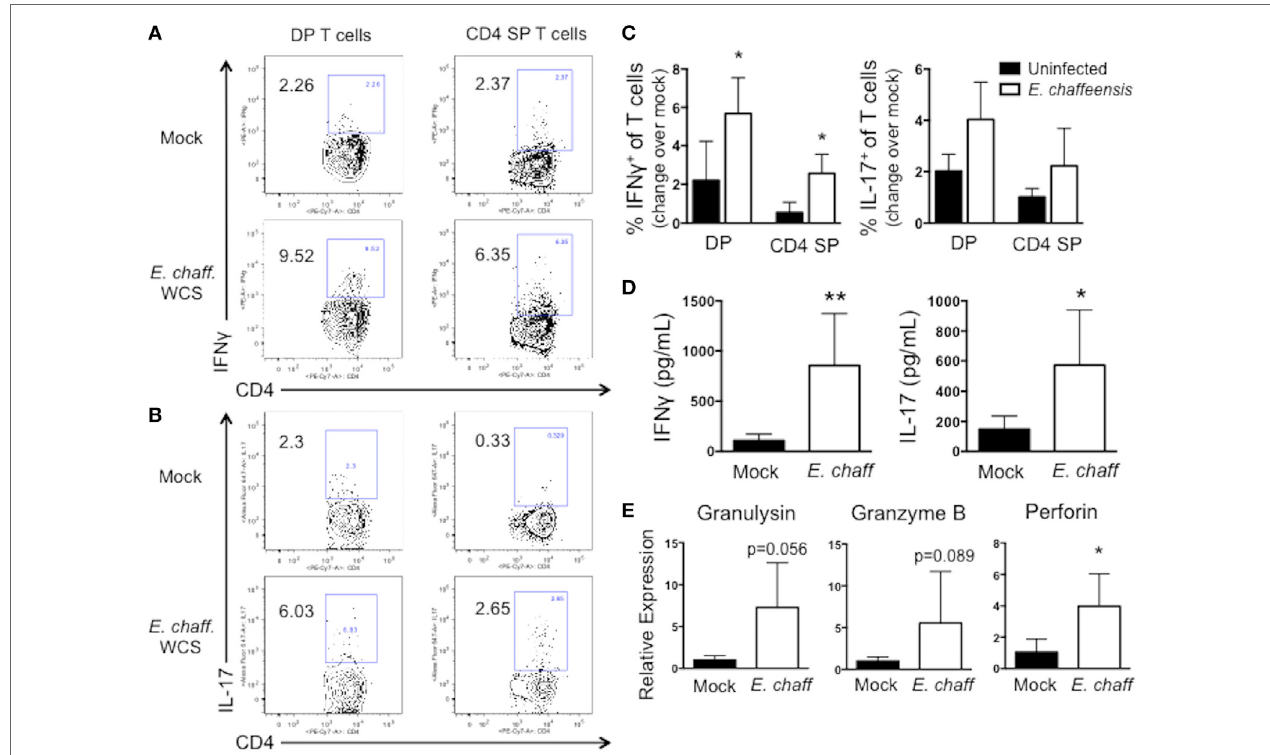
FigUre 5 | CD4 + CD8 + double-positive (DP) T cells from Ehrlichia chaffeensis infected dogs secrete IFN γ and IL-17, and upregulate expression of granzyme B and granulysin, in response to E. chaffeensis antigen. (a) On day 25 post infection, peripheral blood mononuclear cells (PBMCs) were stimulated overnight with 10 µg/ml host cell-free E. chaffeensis lysate in the presence of Brefeldin A. Mock-stimulated samples were used to correct for background cytokine secretion. Cells were fixed and permeabilized, and the frequency of antigen-specific CD3 + CD4 + CD8 + DP T cells and CD3 + CD4 + single-positive (SP) T cells producing IFN γ and IL-17 were assessed by intracellular cytokine staining. Representative flow plots for IFN γ staining are shown in (a) and for IL-17 are shown (B) . Aggregate results are depicted in (c) . * p < 0.05 compared to uninfected controls (group 3) as determined by one-way ANOVA with Tukey’s post-test. (D) On day 28 post-infection, CD3 + CD4 + CD8 + T cells were FACS purified from the peripheral blood of six E. chaffeensis -infected dogs and were cultured for 5 days with autologous monocytes in the presence or absence of 10 µg/ml E. chaffeensis antigen. Cell culture supernatants were then analyzed by commercial sandwich ELISA for IFN γ and IL-17. ** p < 0.01, * p < 0.05 compared to mock-stimulated cells as determined by Student’s t -test. (e) On day 21 post infection, CD3 + CD4 + CD8 + T cells were FACS purified from the peripheral blood of six E. chaffeensis infected dogs and were cultured for 18 h with autologous monocytes and 10 µg/ml E. chaffeensis antigen. The RNA was isolated from the co-cultures and analyzed by qPCR for expression of granzyme B, granulysin, and perforin. Results were normalized to the housekeeping gene GAPDH and then expressed relative to unstimulated control cultures. Data represent mean ± SEM. * p < 0.05 compared to mock-stimulated cells as determined by Student’s t